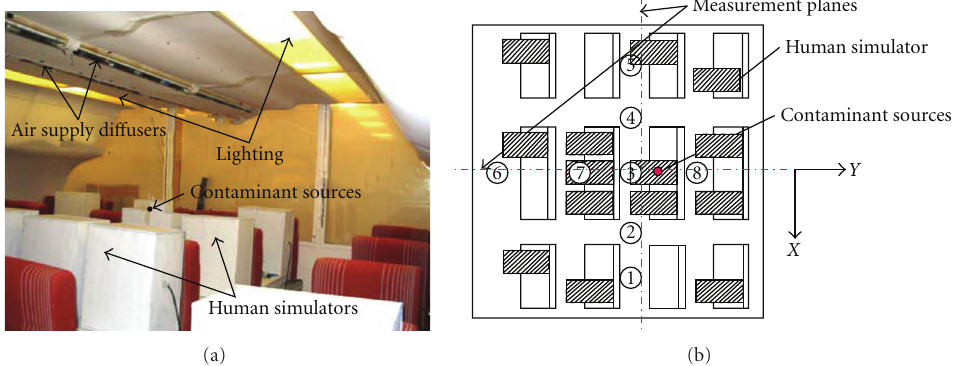
Figure 9: Aircraft cabin mockup to study the dispersion of expiratory particles. (a), the interior of the mockup. (b), top view with measure- ment planes [42].